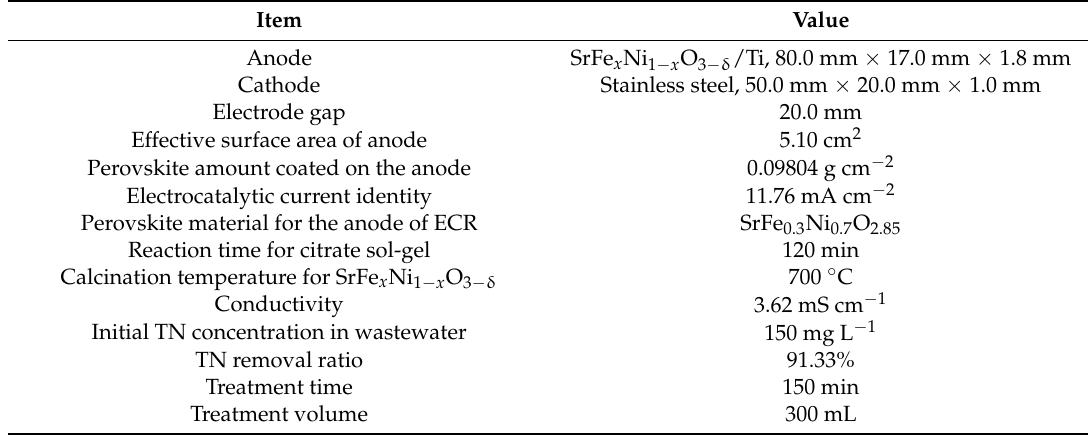
Figure 8. The effect of electrocatalytic time on TN concentration. Table 3. The optimum operation conditions and performance of ECR with the SrFe x Ni 1 − x O 3 − δ /Ti